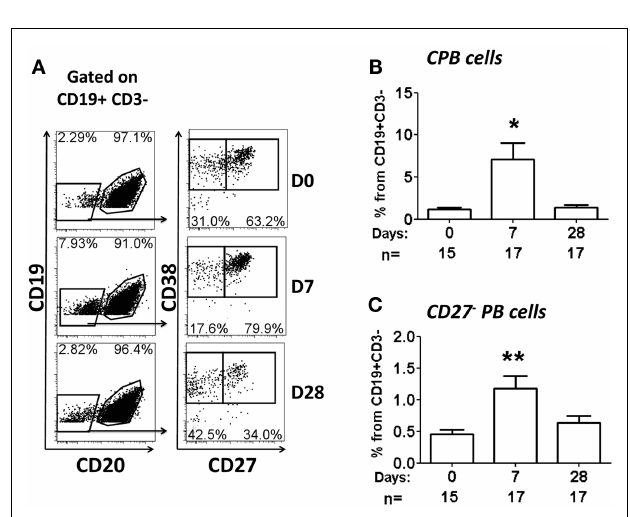
FIGURE 4 | Gating strategy for “conventional plasmablast” (CPB) and “CD27 − plasmablast” (CD27 − PB) cells . Example of gating strategy used (day 0) in a representative volunteer. CPB cells were defined as CD19 dim CD20 − CD27 + (high) CD38 + (high) (IgD − IgG − IgA − ). CD27 − PB cells were defined as CD19 dim CD20 − CD27 − CD38 + (high) (IgD − IgG − IgA − ). Expression of the homing molecules integrin α 4 β 7 and CD62L was determined in both subpopulations. P indicates cells expressing only CD62L, which home